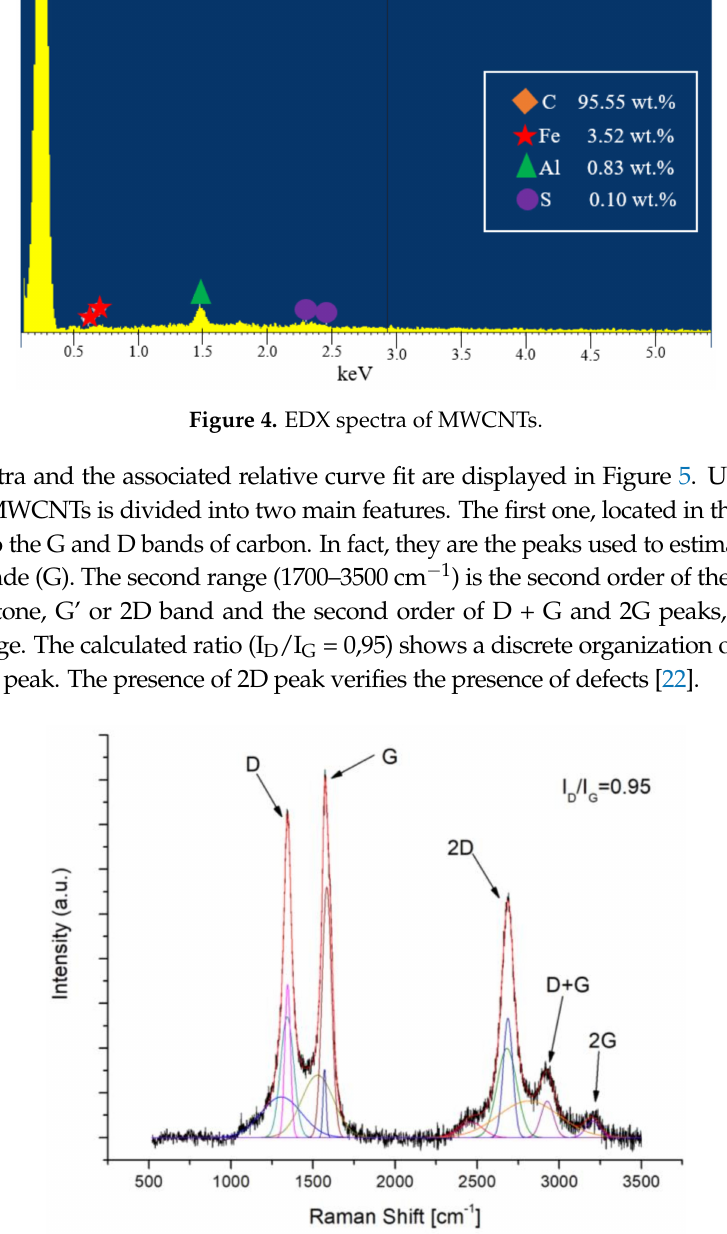
Figure 5. Raman spectra and its